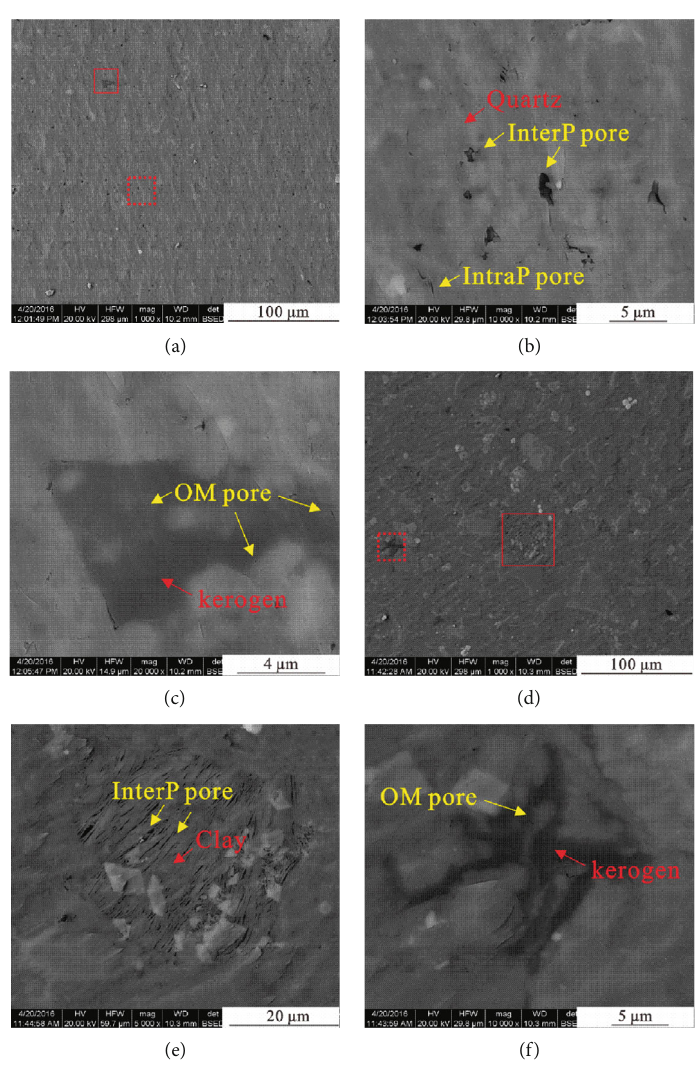
Figure 2: FE-SEM images for the samples of C7 shale. (a – c) BMHS; (d – f)